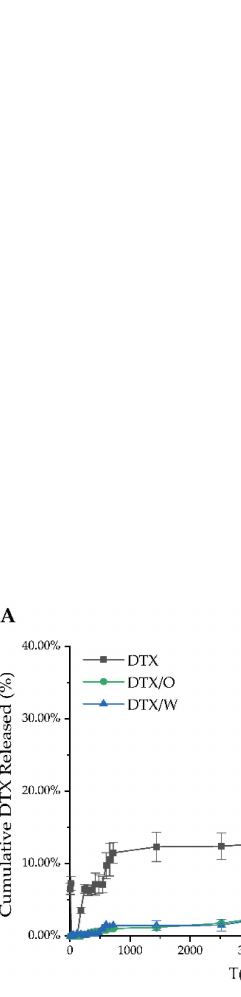
Figure 7. The transdermal release profiles of DTX solution, DTX/O-containing emulsion and DTX/W- containing emulsion in phosphate buffer saline containing 10% ethanol: ( A ) Mouse skin; ( B ) Mouse subcutaneous